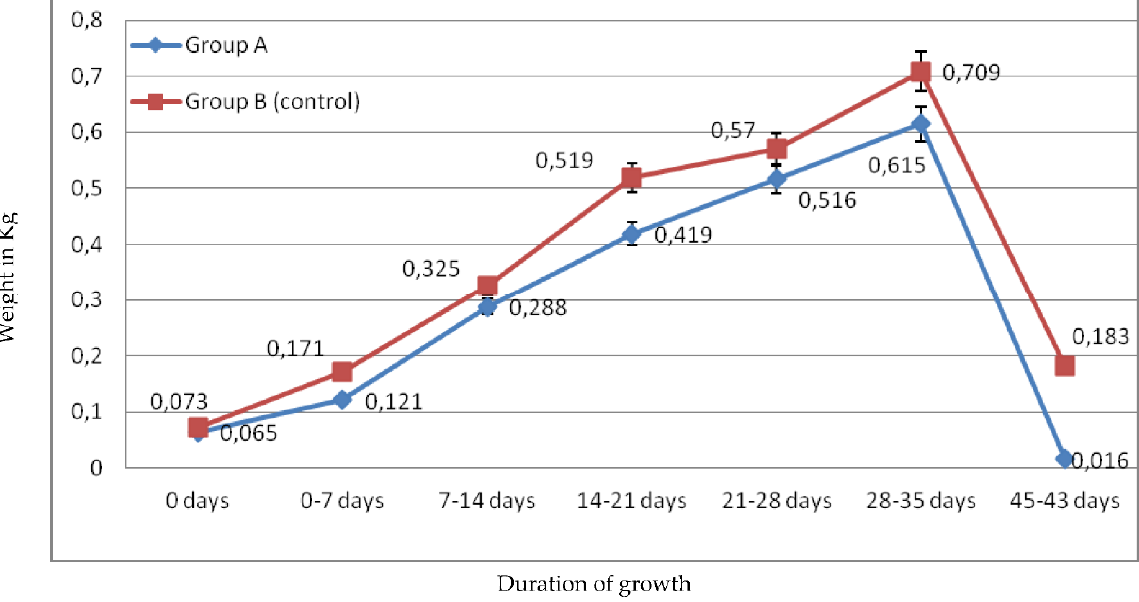
Figure 3. Broiler average growth rate/week. Broilers of group A, fed with ration supplemented with pulp and seeds of pomegranate and avocado by-products, and broilers of group B (control group), fed with basal ration. Regarding average weekly feed consumption/broiler, it was observed from Figure 2 that, in the first 7 days, it consumed 0.244 kg and 0.236 kg /broiler for group A and group B, respectively. Broilers of group A consumed, in total, more feed during the experiment (122.150 kg), while broilers of group B consumed 110.720 kg. The